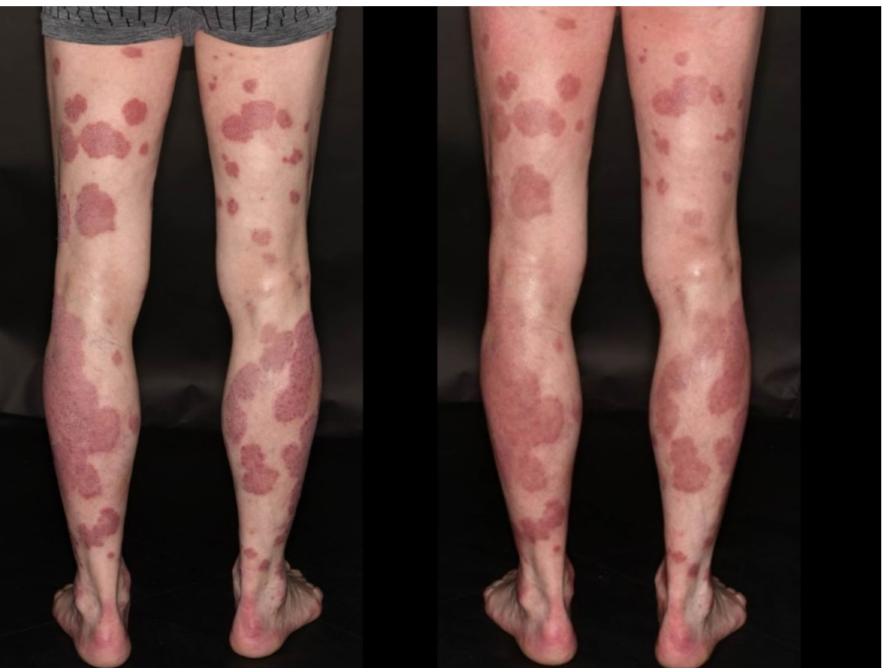
Figure 5. Clinical appearance featuring a persisting exacerbation of scaling erythematous plaques on the lower extremities after having received two doses of BNT162b2 ( left ), and remaining lesions after two weeks of balneophototherapy using dithranole and narrowband ultraviolet B 311nm in our clinic ( right